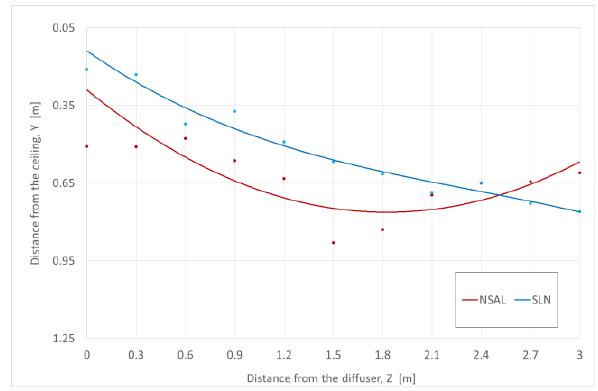
Fig. 14 . Comparison of ranges of tested diffusers at 480 m 3 /h flowrate, outflow lateral (along with the